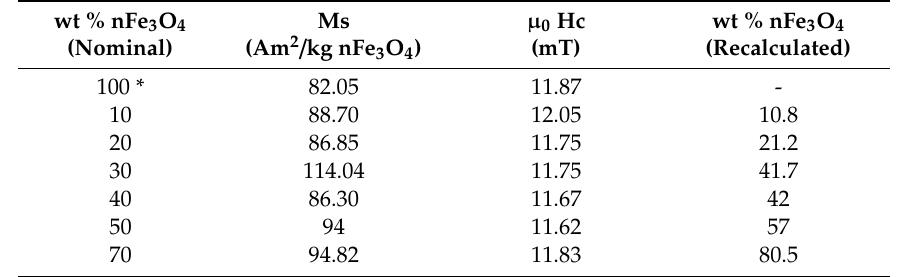
Figure 2. Magnetization curves of pure (100%) nFe 3 O 4 and PLLA-nFe 3 O 4 scaffolds normalized to the nominal nFe 3 O 4 content. The inset shows the initial part of the curves and discloses the coercivity, which is the same for all samples. Table 1. Saturation Magnetization (Ms) normalized to the nominal content of nFe 3 O 4 , Coercivity (µ 0 Hc) and true nFe 3 O 4 content recalculated from the saturation magnetization.